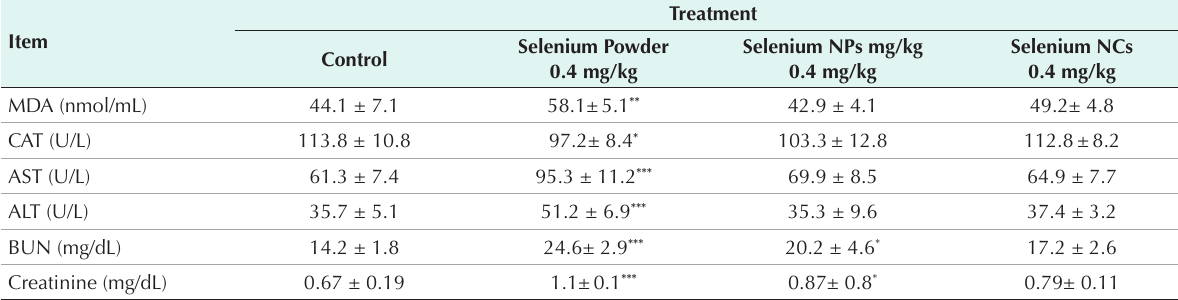
Table 1. Effects of Se NPs on Serum Biochemical Parameters in Rats